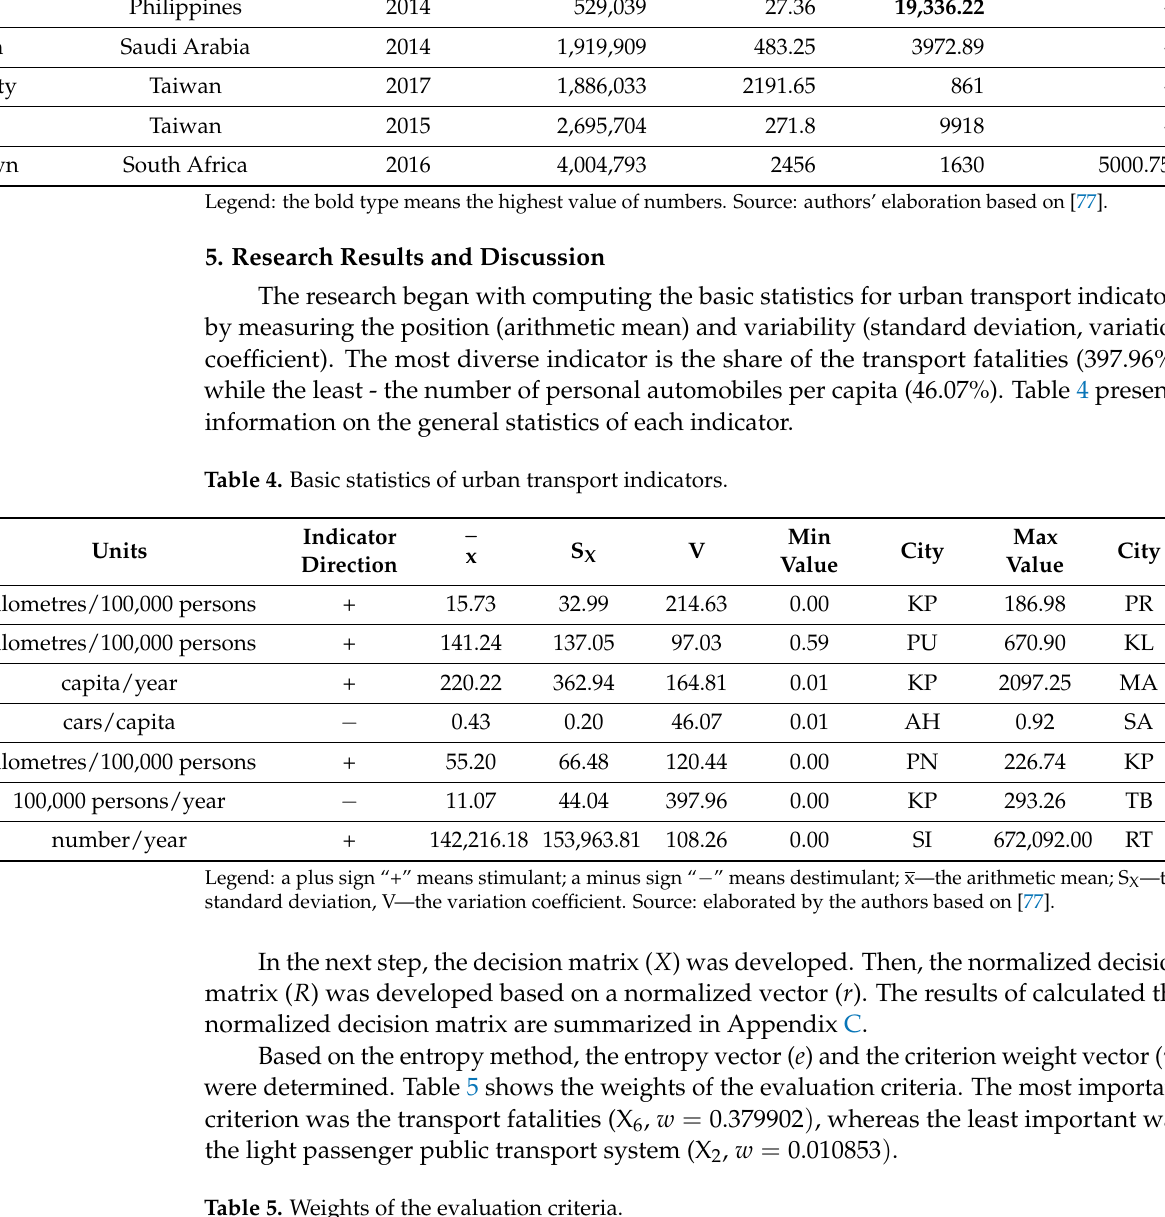
Table 5. Weights of the evaluation